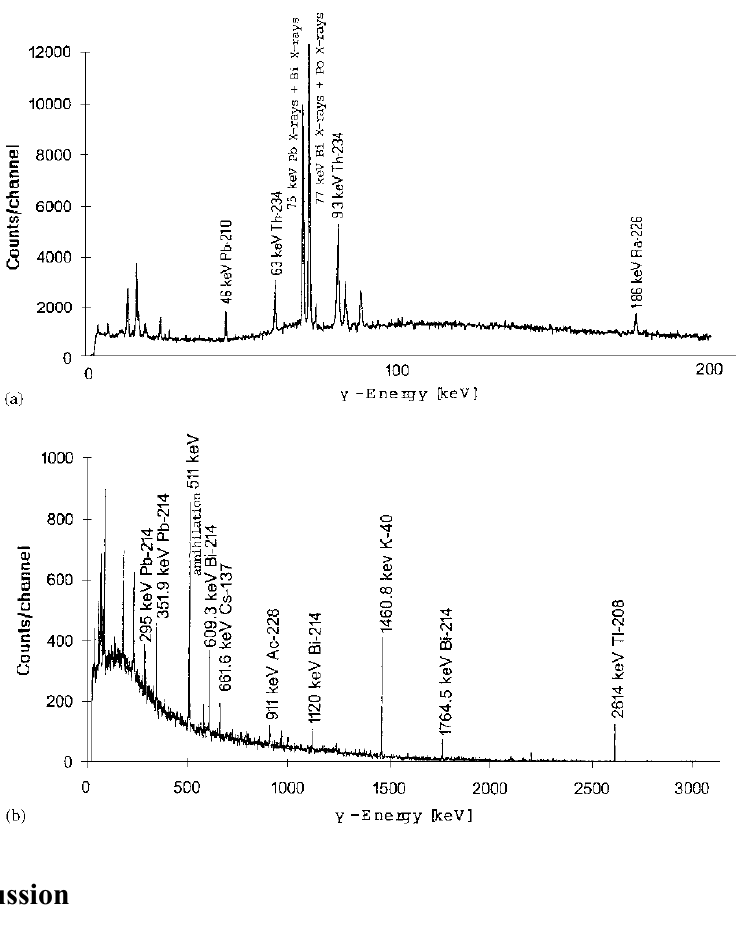
Figure 2. Gamma-ray spectrum of tobacco leaves. (a) Gamma photon energies ranging up to 186 keV obtained with planar detector. (b) Gamma photon energies ranging up to 2614 keV obtained with coaxial